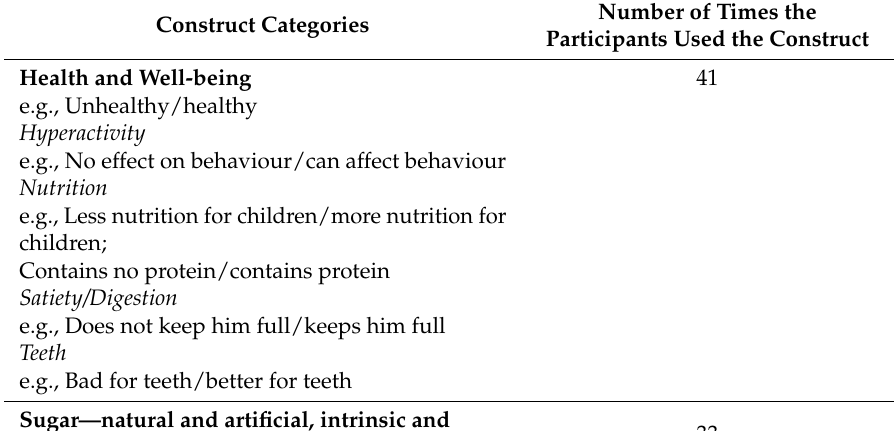
Table 2. The six main categories of constructs elicited from the mothers. Construct Categories